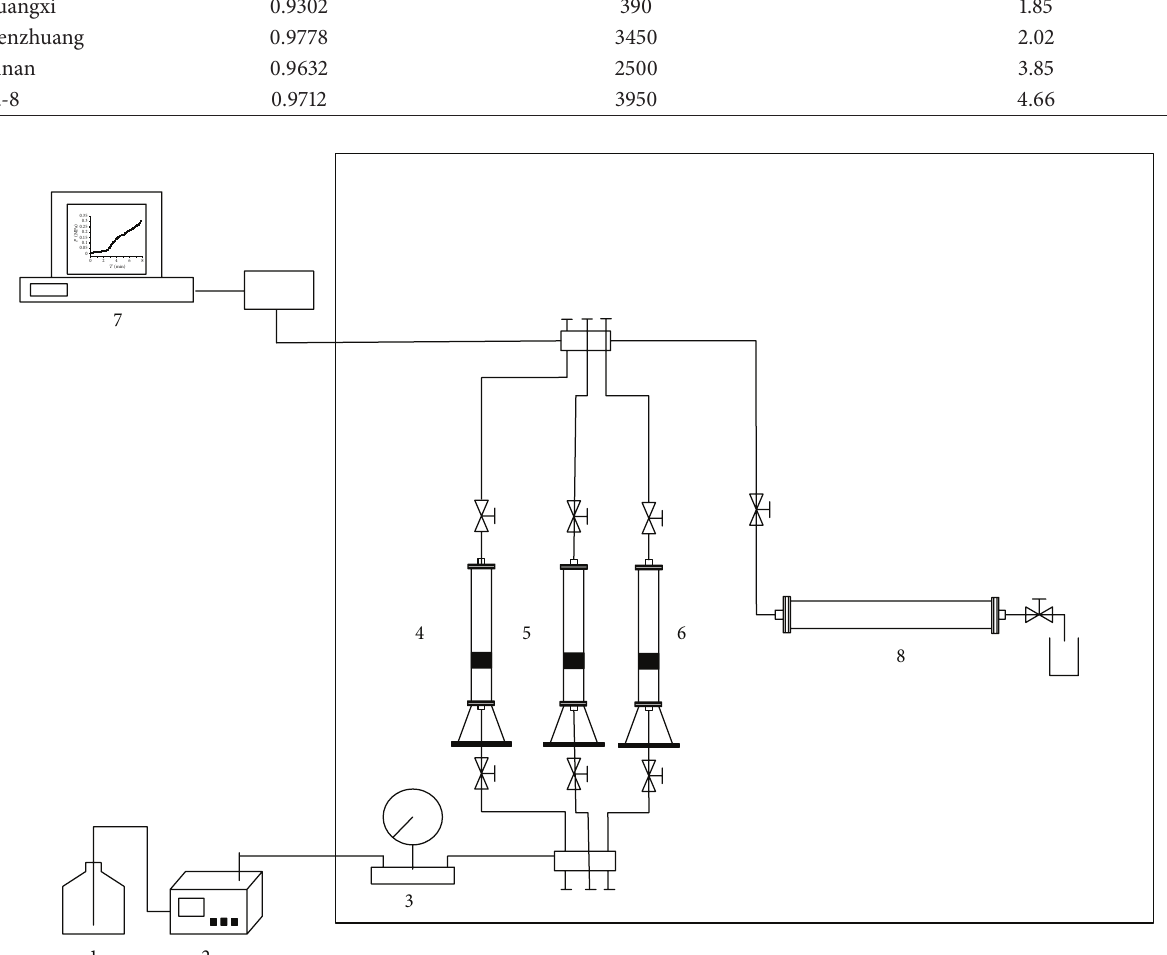
Figure 2: The equipment for sandpack flooding. 1, distilled water; 2, pump; 3, pressure meter; 4, brine water container; 5, crude oil container; 6, alkaline solution container; 7, pressure collection system; 8, Sandpack